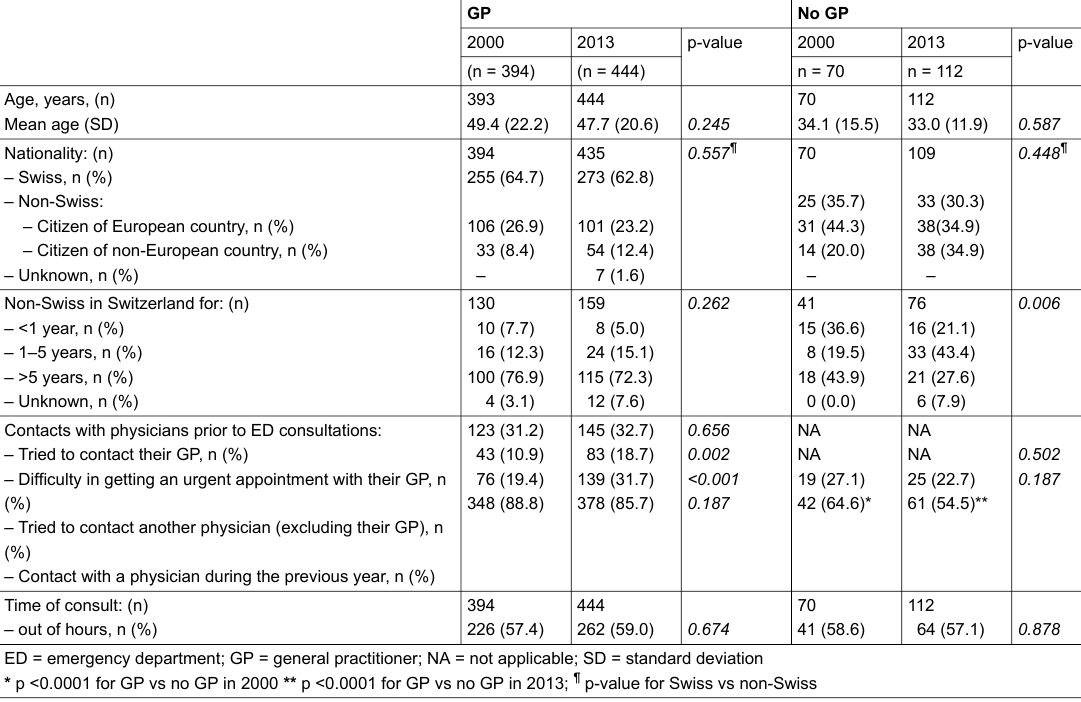
Table 2: Evolution between 2000 and 2013 of the characteristics of patients with and without a general practitioner (GP).